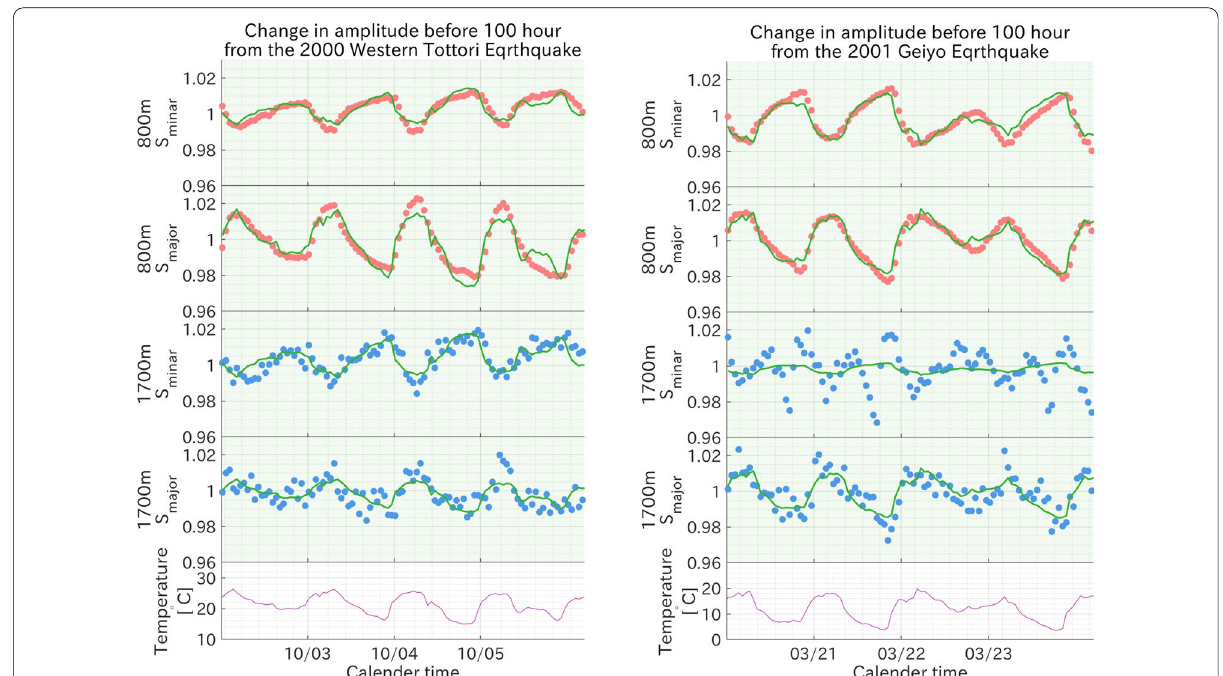
Fig. 14 The temperature effect in the amplitude variation. The amplitude variation (blue and red dots) in major and minor axes of principal axes and fitting with variation in atmospheric temperature (green lines) are shown from 100 h before the occurrence of WT and GY. The top two rows show the results for the 800-m sensors and the next two rows show those for the 1700-m sensors. The bottom row shows variation in atmospheric temperature. The left and right panels show the results for the WT and GY earthquakes,